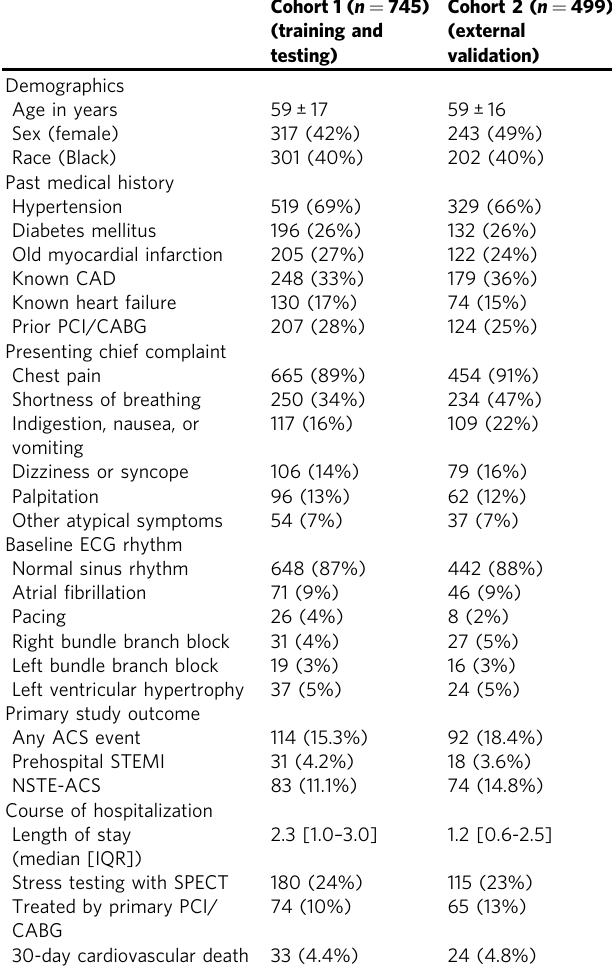
Table 1 Baseline patient characteristics.